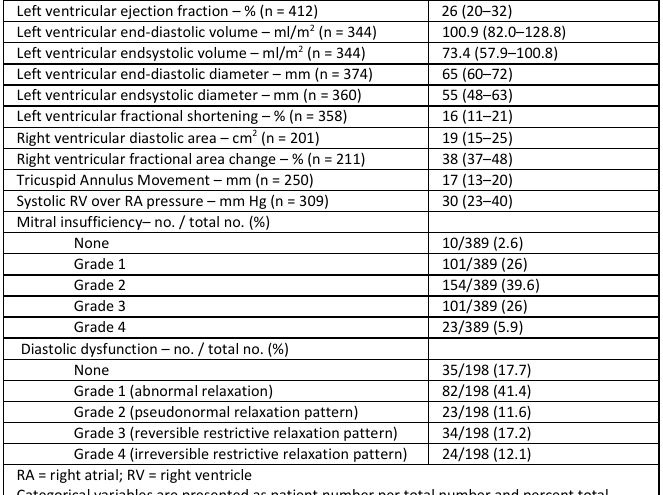
Table S3: Echocardiographic characteristics at the time of cardiac resynchronisation therapy device implantation. Left ventricular ejection fraction – % (n = 412)